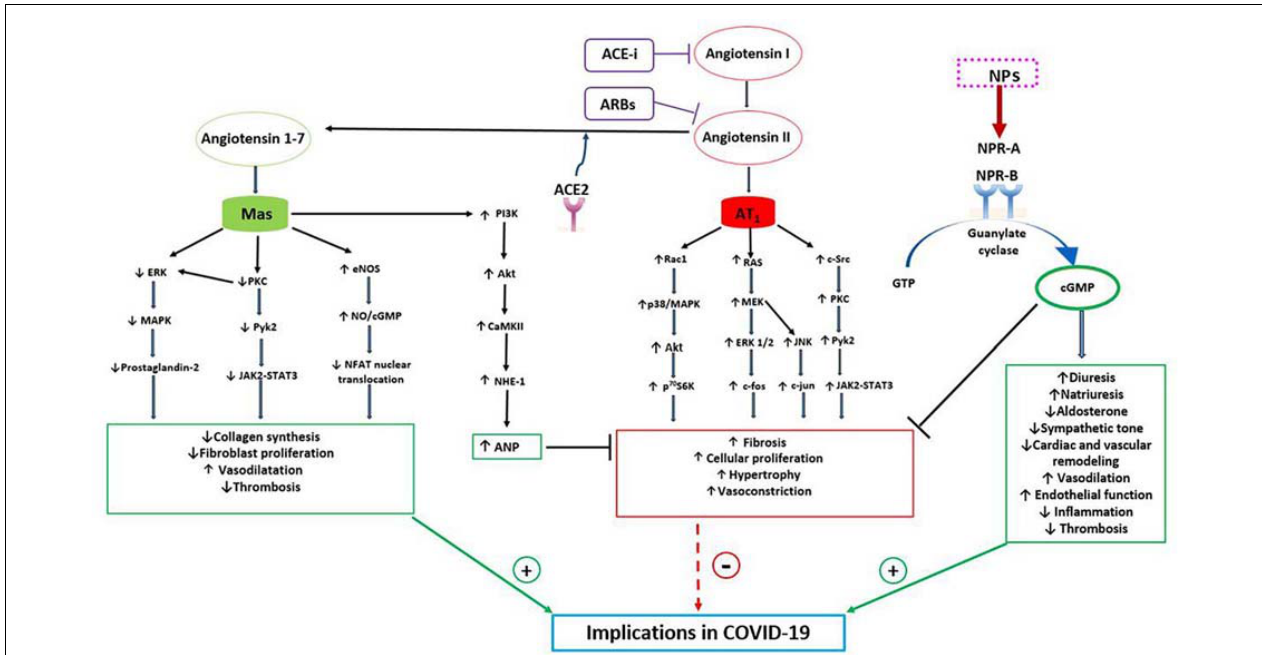
FIGURE 1 | Bidirectional interaction between NPs and RAAS with potential implications in COVID-19. The RAAS may exert both protective and detrimental effects. Angiotensin II, through its receptor AT1, activates signaling pathways involved in fibrosis, cellular proliferation, hypertrophy and vasoconstriction. Indeed, AT1 stimulates the RAC1/p38/MAPK pathway which is involved in the activation of Akt, mTOR and its downstream target p 70 S6K. Moreover, AT1 activates both Ras/MEK/ERK pathway, which leads to an increased expression of c-fos mRNA, and JNK, which increases cJUN activity. AT1 also induces c-Src which, through PKC and PyK2, a non-receptor tyrosine kinase, stimulates JAK2-STAT3 signaling pathway. On the other hand, the protective arm of the RAAS is driven by ACE2-Ang (1-7)-Mas receptor, which plays complementary functions to the Angiotensin II-AT1 receptor. Mas receptor, indeed, reduces the activation of the MAPK, ERK and JAK2-STAT3 signaling pathways and increases the eNOS/NO pathway, down-regulating the NFAT transcription factor activity. As a consequence, Mas receptor activation reduces collagen synthesis, fibroblast activation and thrombosis. Moreover, Mas receptor activates PI3K/AKT and consequently CAMKII and NHE-1, increasing ANP gene expression, which further contributes to the protective role of ACE2-Ang (1-7). NPs indeed counteract the salt-retaining, vasoconstrictive, pro-inflammatory, pro-hypertrophic and pro-fibrotic functions of AT1. Through the stimulation of NPR-A and NPR-B and the production of cGMP, NPs increase diuresis, natriuresis, endothelial function and vasodilatation and reduce aldosterone production, sympathetic tone, inflammation and cardiac remodeling. As a consequence of their properties, NPs and Ang (1-7) may play a protective role during COVID-19 infection, reducing systemic inflammation, thrombosis, myocardial, lung and renal injury and improving prognosis. CAMKII, Ca 2 + /calmodulin-dependent protein kinase II; eNOS, endothelial nitric oxide synthase; ERK, extracellular-signal-regulated kinase; JAK, Janus kinase; JNK, c-JUN N-terminal kinase; MAPK, p38 mitogen-activated protein kinase; MEK, mitogen-activated protein kinase; NFAT, nuclear factor of activated T cells; NHE-1, sodium-hydrogen antiporter 1; NO, nitric oxide; p 70 S6K, ribosomal protein S6 kinase beta-1; PIK3, phosphatidylinositol 3-kinase; PKC, protein kinase C; PyK2, proline-rich tyrosine kinase 2; Rac1, Ras-related C3 botulinum toxin substrate; STAT3, signal transducer and activator of transcription